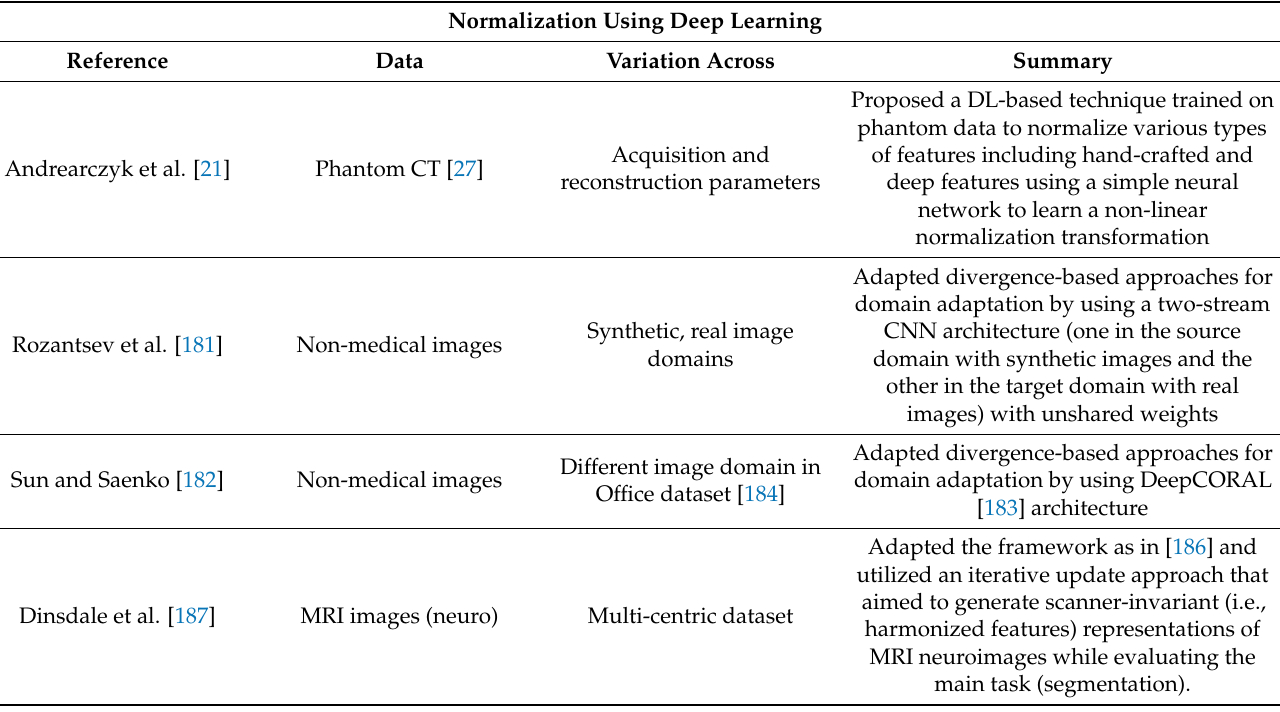
Table 9. Summary table of normalization methods using deep learning